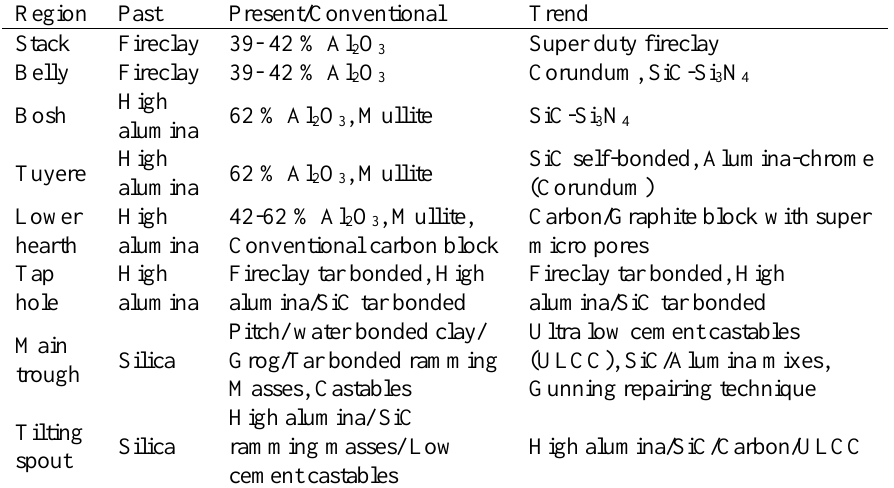
Table 2. The blast furnace refractory lining [10,